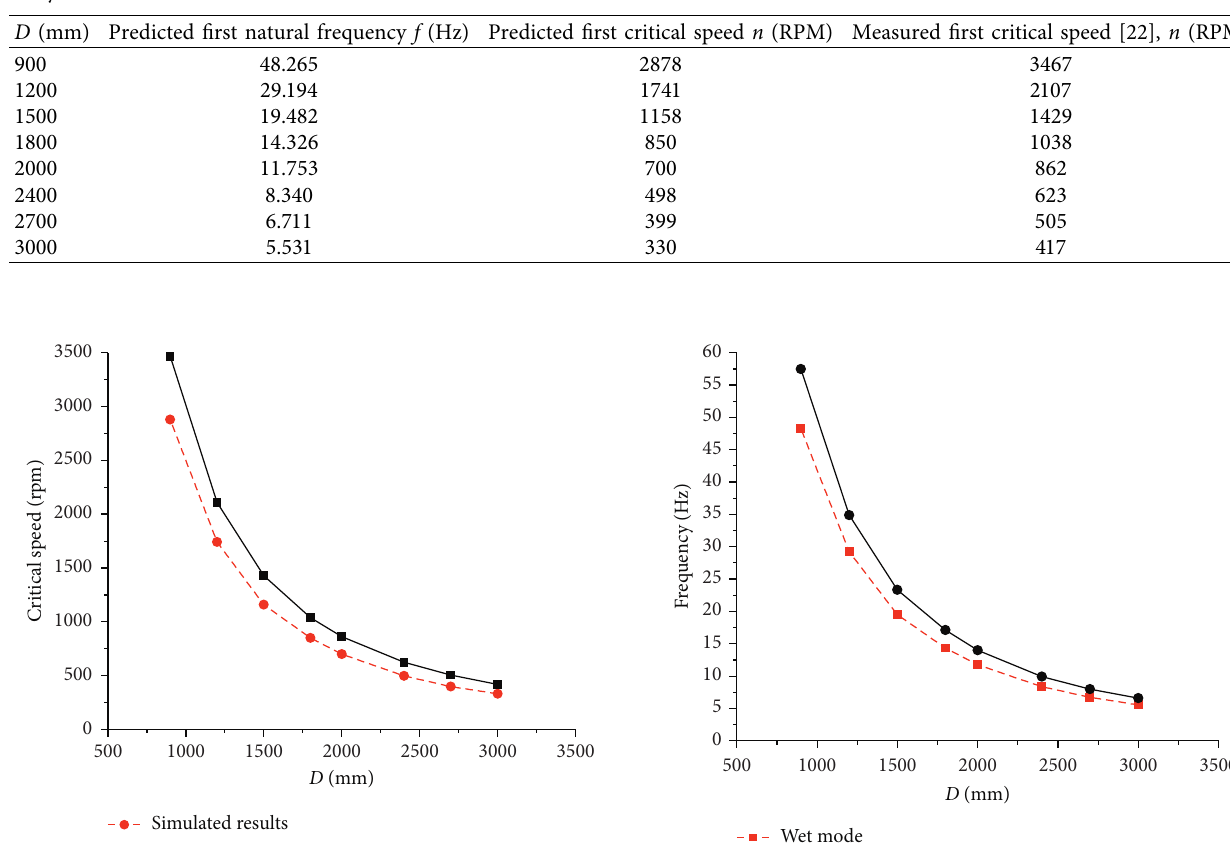
Figure 9: Natural frequencies of the rotor for D � 1500. Table 8: Predicted first natural frequencies and measured [22] and predicted critical speeds for various rotor lengths from the wet mode analysis.